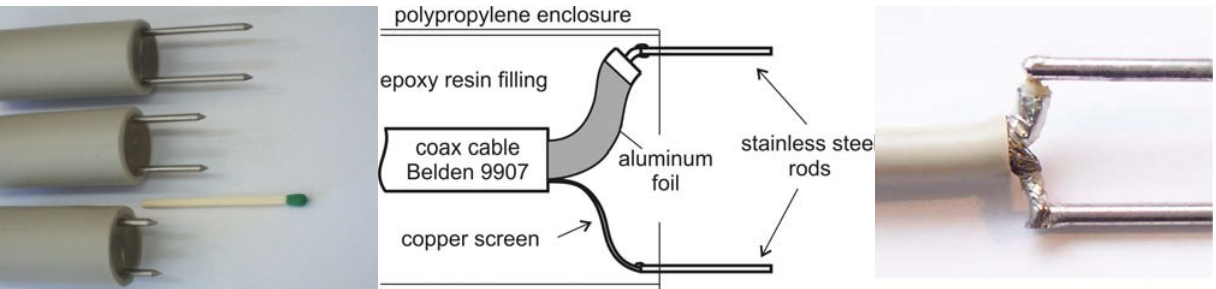
Figure 1. Two wire stainless steel rod FDR probes (left), the scheme of internal details (middle) and the interface between coaxial and parallel waveguides